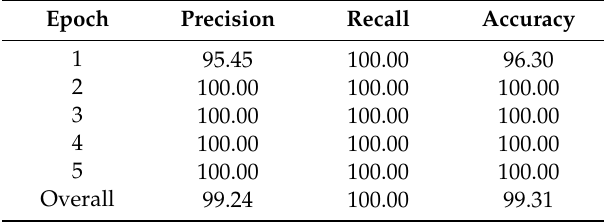
Figure 7. Epoch 1: ( a ) point cloud; ( b ) robust planar and linear classification and segmentation. The process of automated column identification: ( c ) histogram of the x − y components of normal vector; ( d ) planar surfaces satisfying the orientation and orthogonality criteria; ( e ) identified columns (segmented planar surfaces satisfying the boundary conditions); ( f ) generated 3D as-built model of the column and floor. Table 2. Precision, recall, and accuracy of the automated column extraction for each